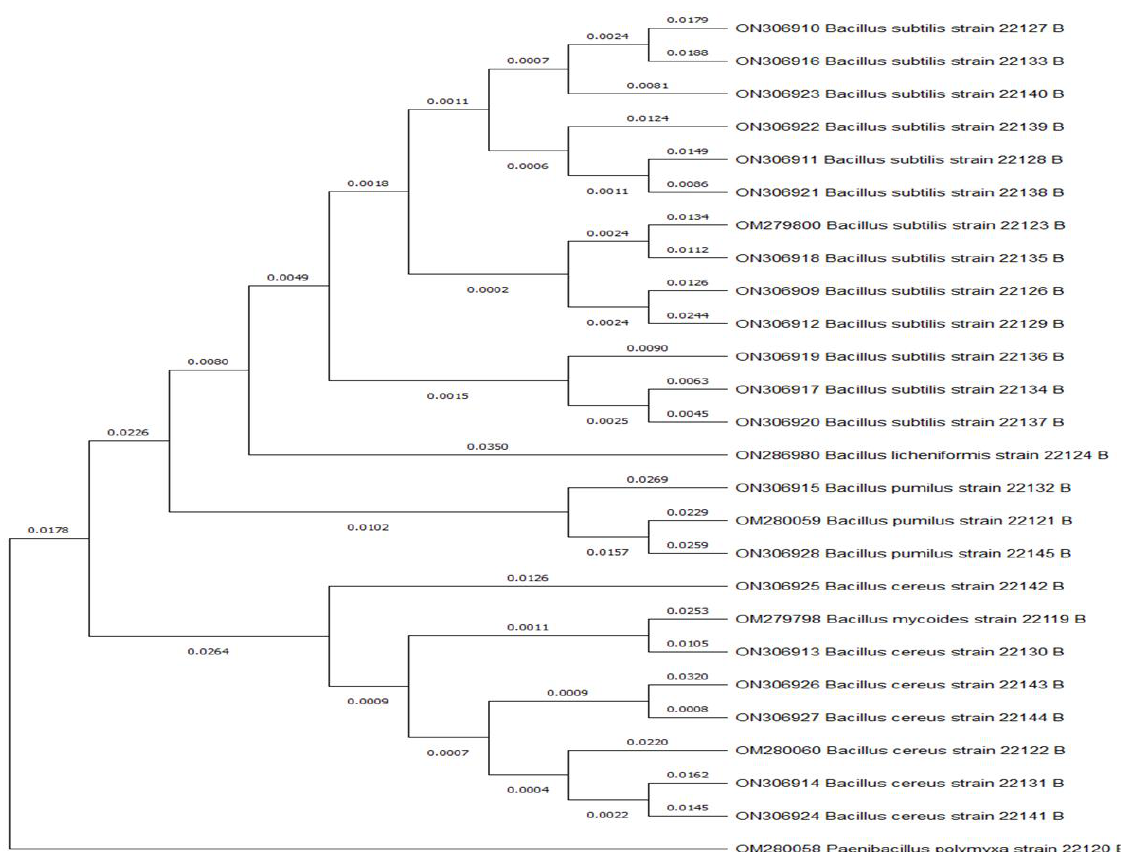
Figure 5. Phylogenetic tree showing distance between sequences of 16S rDNA of Bacillus isolates constructed by the method of